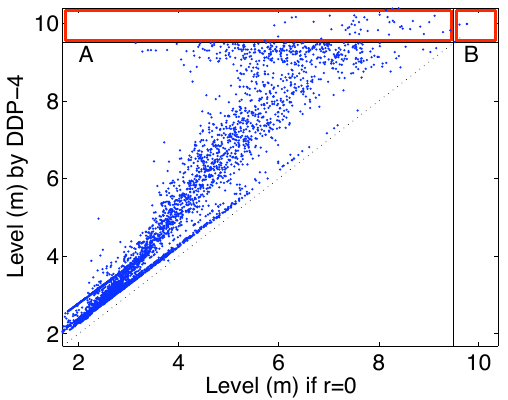
Fig. 6. Water level at Hanoi when the HoaBinh release is perma- nently equal to zero (horizontal axis) and produced by DDP-21 (ver- tical